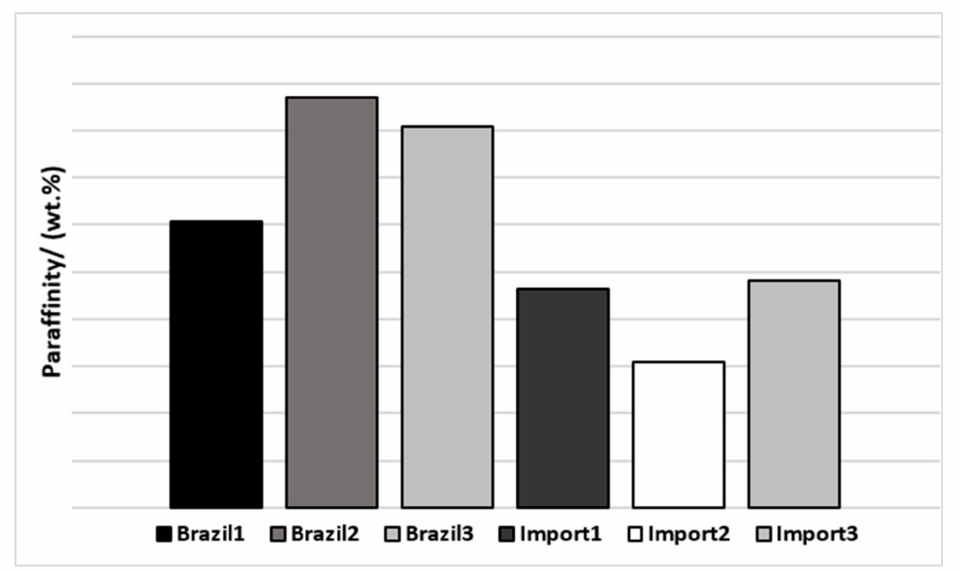
Figure 4. Paraffinity of naphtha’s samples by